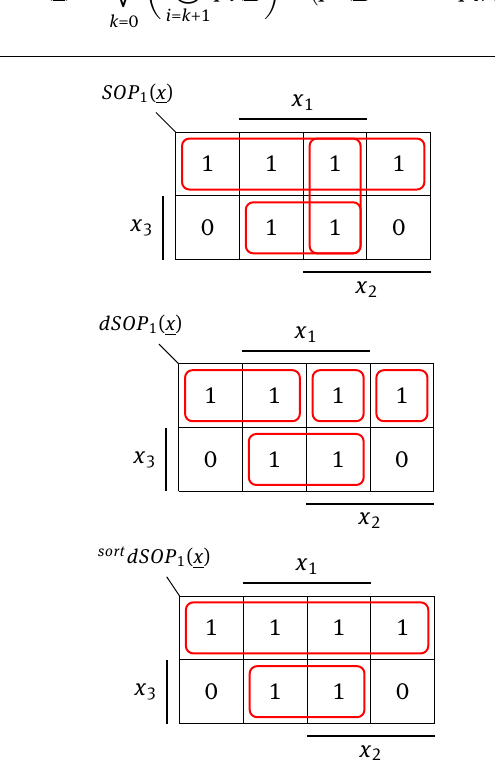
Figure 3: Comparison of SOP 1 ( x ) , dSOP 1 ( x ) and sort dSOP 1 ( x )